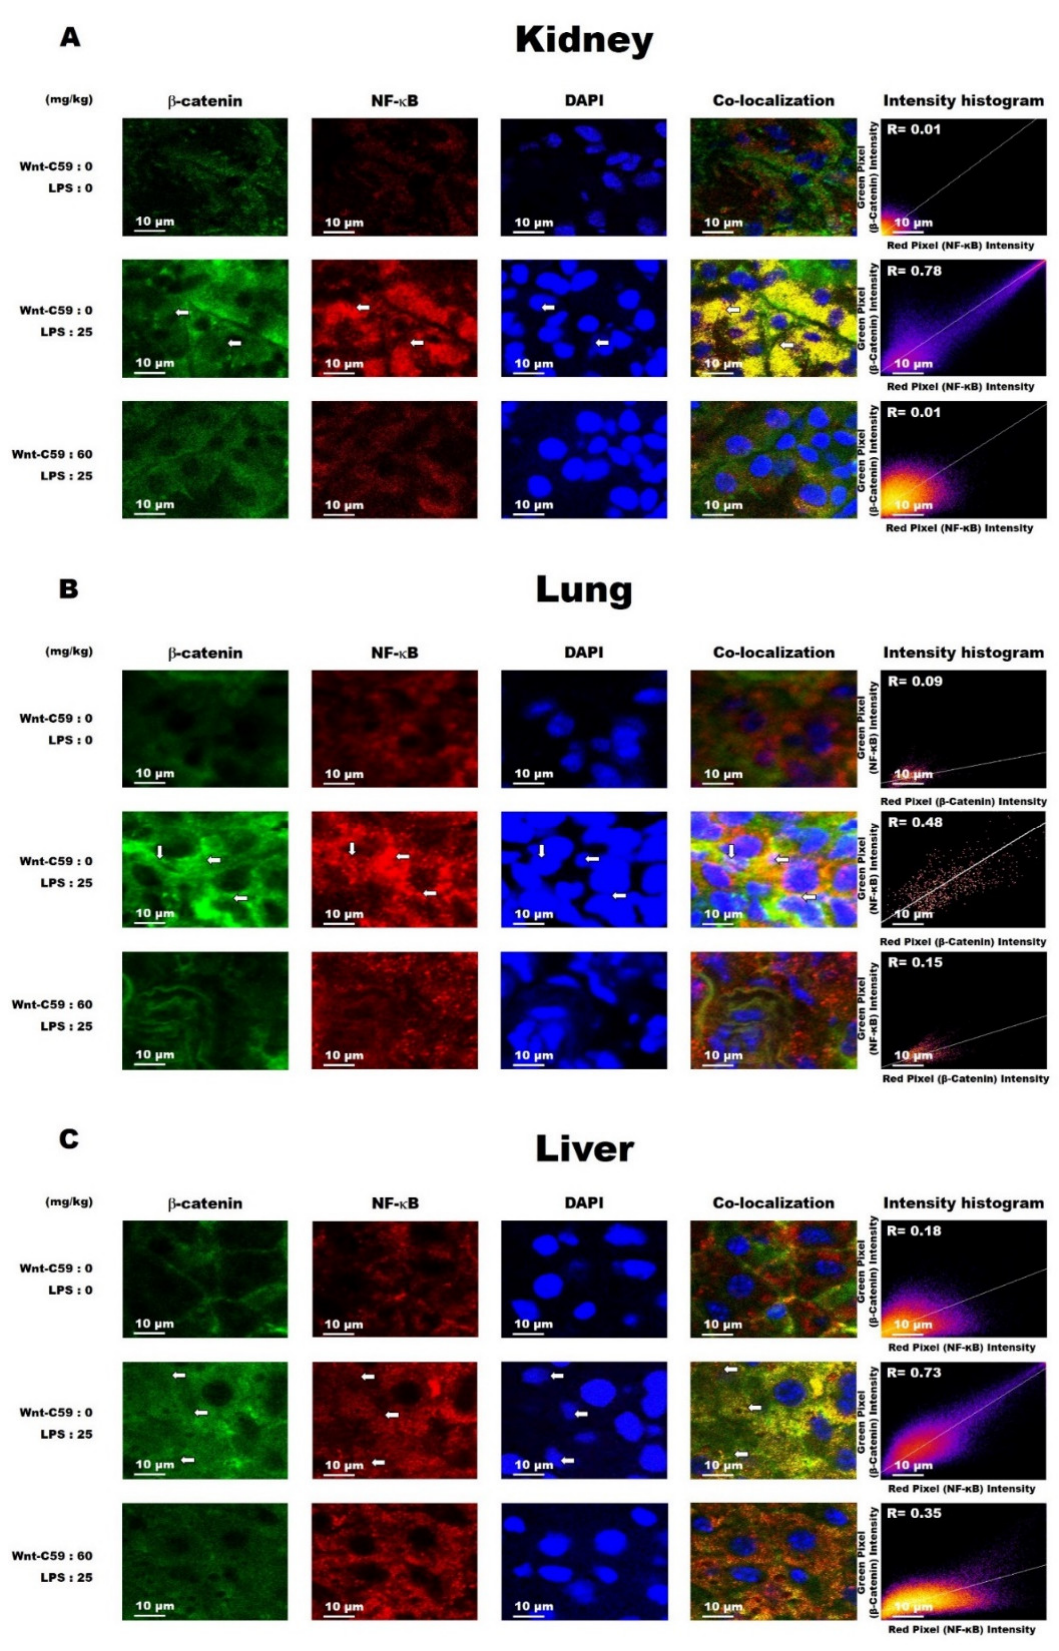
Figure 5. Wnt-C59 suppressed the co-localization of β -catenin and NF- κ B in multiple organs of endotoxemic mice. Mice were i. p. injected with 0 or 60 mg/kg of Wnt-C59 and then with 25 mg/kg of lipopolysaccharide after 2 h. The control